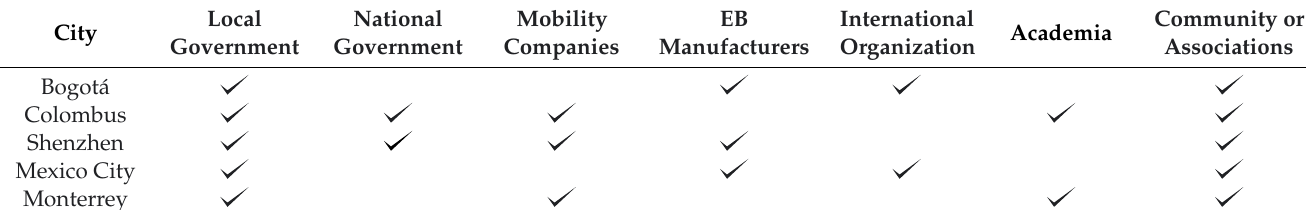
Table 3. Stakeholders involved in conscious mobility projects by case